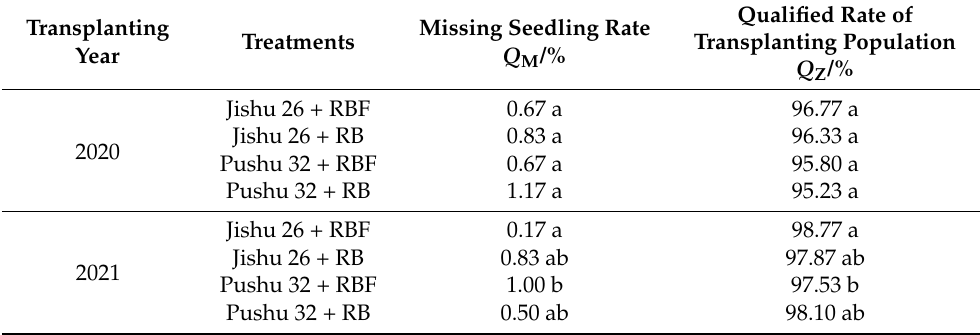
Table 1. Transplanting quality of the 2CGFS-2 compound sweet potato transplanter for two sweet potato cultivars under RBF and RB cultivation systems in 2020 and 2021. Note: Means of the same year within a column followed by the same letters are not significantly different at p = 0.05.